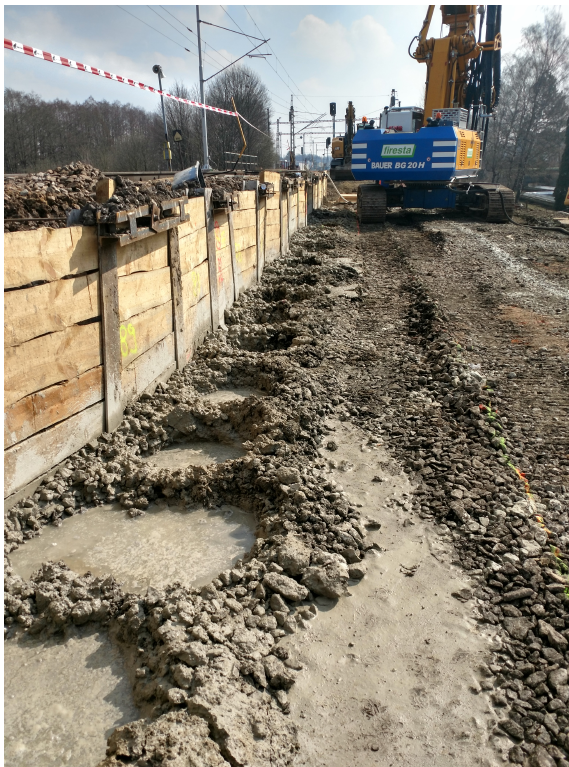
Figure 6. Construction of DSM columns at the Žďár nad Sázavou building